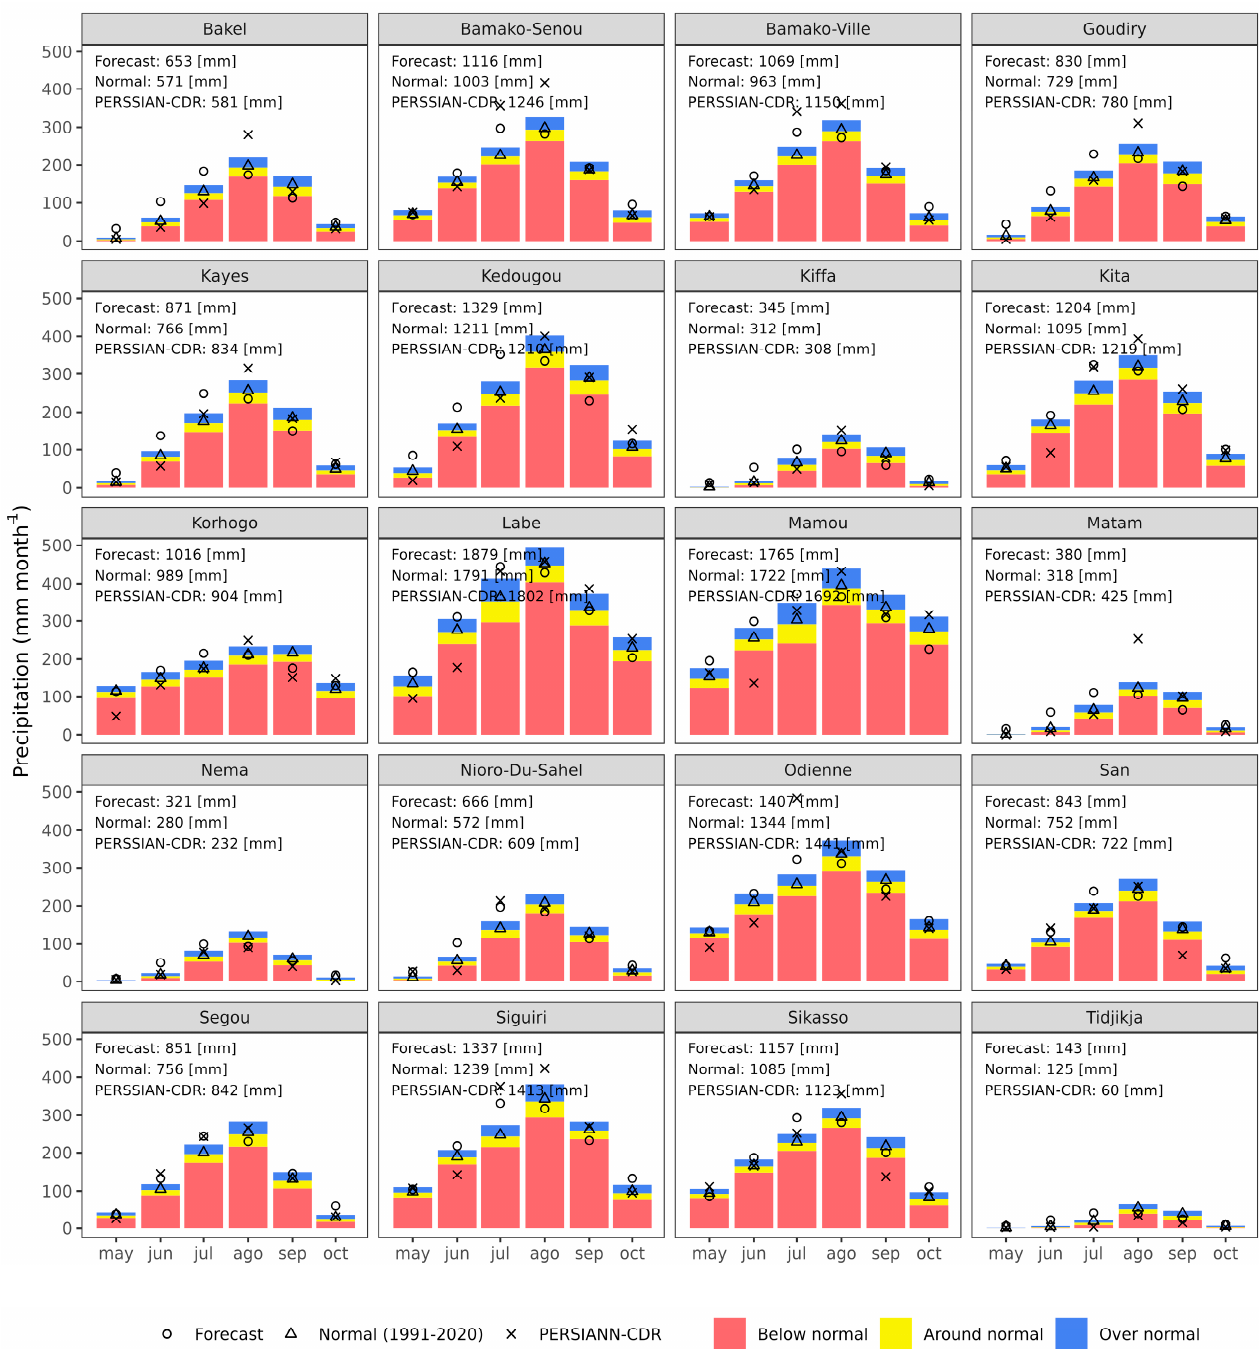
Figure 6. Comparison between the forecast for 2021 and PERSIANN-CDR monthly rainfall (mm) using the monthly frequency hyetograph (MFH) of the pixel where the rain gauge is located. When comparing the average rainfall of the forecast for the year 2021 with the normal precipitation, 90% of the area corresponds to wet regions (Figure 7). In the south region of the Bani and Senegal River basins and in the northern end of the Senegal River basin, the forecast is classified as around normal.